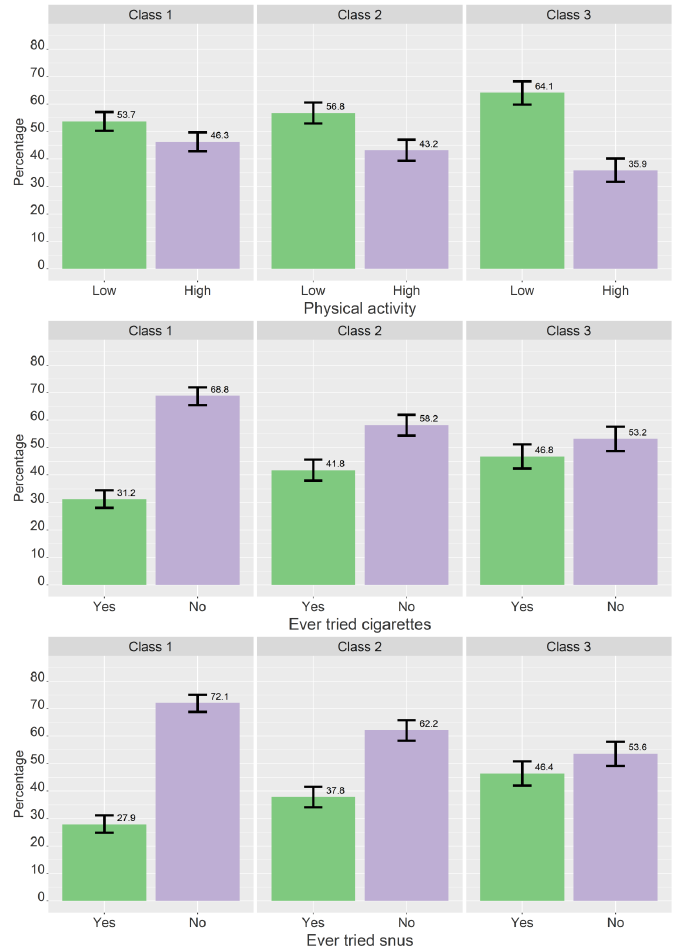
Figure 4. Crude proportions for each class across physical activity, cigarettes (ever tried, yes/no), and snus (ever tried, yes/no). Proportions based on most probable class belongingness. The error bars denote 95% confidence